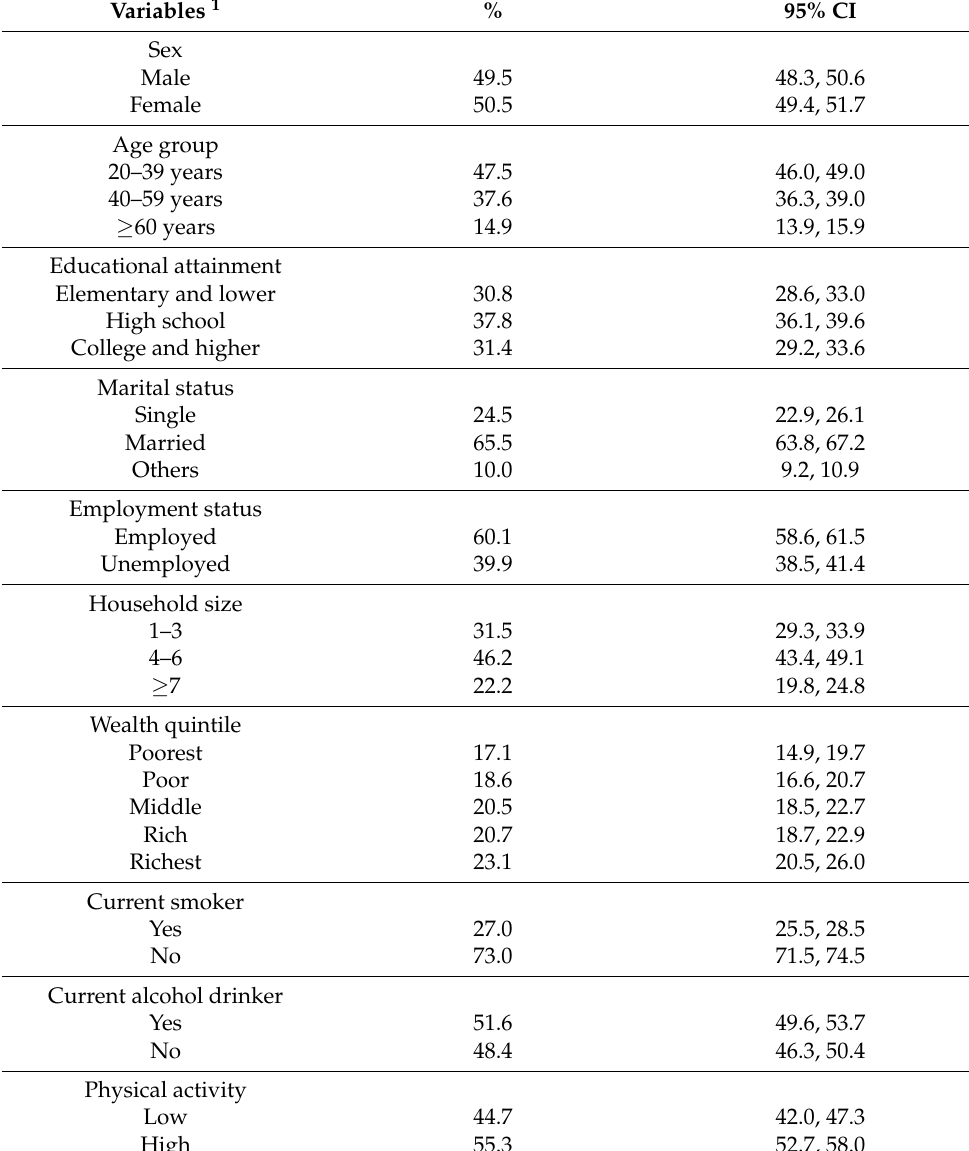
Table 2. Characteristics of the participants by sex ( n =